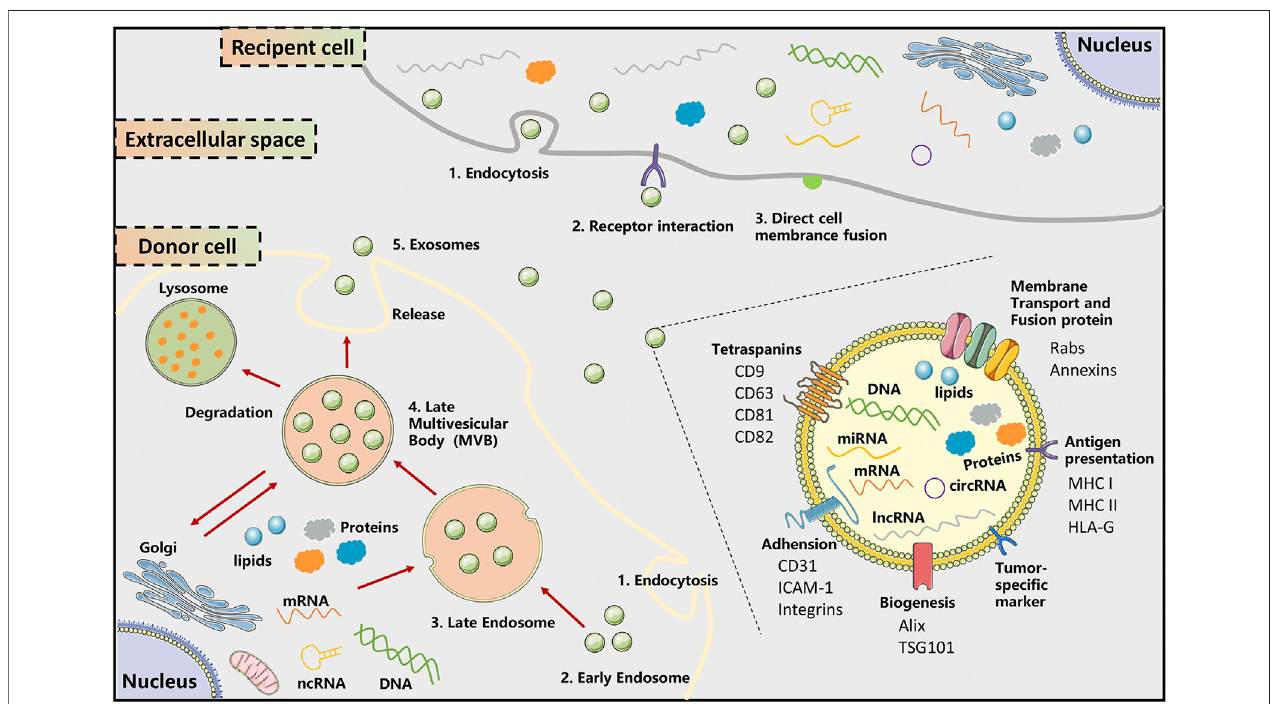
FIGURE 1 | The biogenesis, secretion, and uptake of exosomes. The biogenesis and release of exosomes undergo initiation, endocytosis, multivesicular body (MVB) formation, and exosome secretion. Exosome biogenesis is initiated with the formation of early endosomes that are formed by early endosomes, a process called endocytosis. Then, the incorporation of selected cargos, including multiple proteins, lipids, mRNA, and non-coding nucleic acids, and endosomes resulted in the MVB formation. Finally, SNARE complexes help MVBs fuse with the plasma membrane, releasing intraluminal vesicles into the extracellular space, which is denoted as exosome.Thesereleasedexosomescanbeinternalizedwithrecipientcellsviadirectfusion,endocytosis,andreceptor-ligandinteractions,leadingtoaseriesofcascade events in recipient cells. Exosomes are enriched in a range of conserved proteins, exosome formation-related proteins, and tumor-related proteins. The membrane constituents includetetraspanins(CD9,CD63,CD81,CD82)membrane traf fi ckingand fusionproteins(Rabs,Annexins),adhesion molecular (CD31,ICAM-1,integrins), tumor-speci fi cmarkers,MHCandHLA-G.ThecarriedcargoesarecomprisedofmultiplemRNA,proteins(enzyme,Hsp70,Hsp90),ncRNA(miRNA,lncRNA,circRNA), and metabolites. ICAM-1, intercellular adhesion molecule-1; MHC, major histocompatibility complex; MVB, multivesicular bodies.